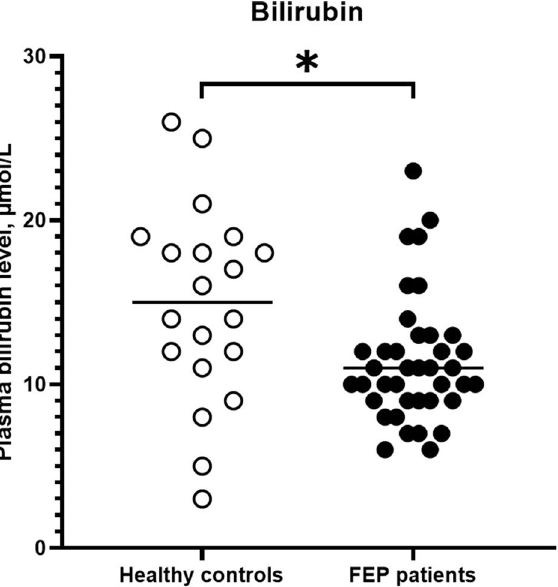
Figure 1. Levels of plasma bilirubin in HC versus individuals with FEP (HC: median 15.0 µM, IQR 11.5– 18.5 µM, n = 20 vs. FEP: median 11.0 µM, IQR 9.0–13.0 µM, n = 39, p value 0.014). Horizontal lines represent the median for each group. Abbreviations: FEP, First episode psychosis. Statistical differences were determined using the Mann–Whitney U-test, two-sided. * p value <